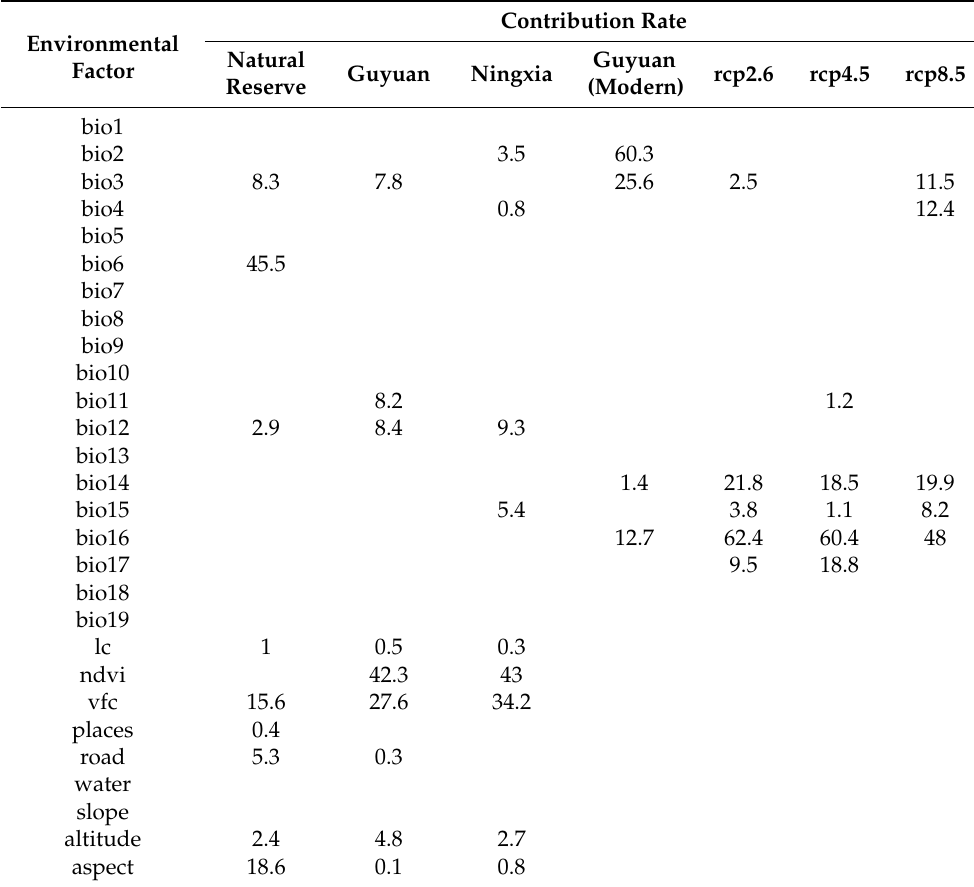
Table 3. The contribution rate of environmental factors in the MAXENT model under different geographical scales and future climate